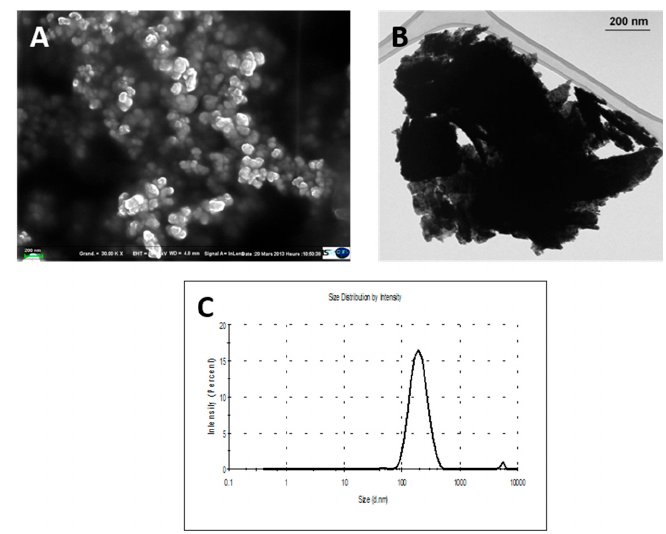
Figure 2. Morphometric analysis and International Thermonuclear Experimental Reactor (ITER)-like milled W-NPs size determination. W-NPs solutions resulted polydispersed, as shown by SEM ( A ) and TEM ( B ). The dispersion of particles in Tris (pH 8.5) was analyzed by dynamic light scattering (DLS; C ). The mean intensity ± standard deviation (SD) corresponded to 202 ± 68 nm, and polydispersity index = 0.307 ± 0.02 ( n = 3).